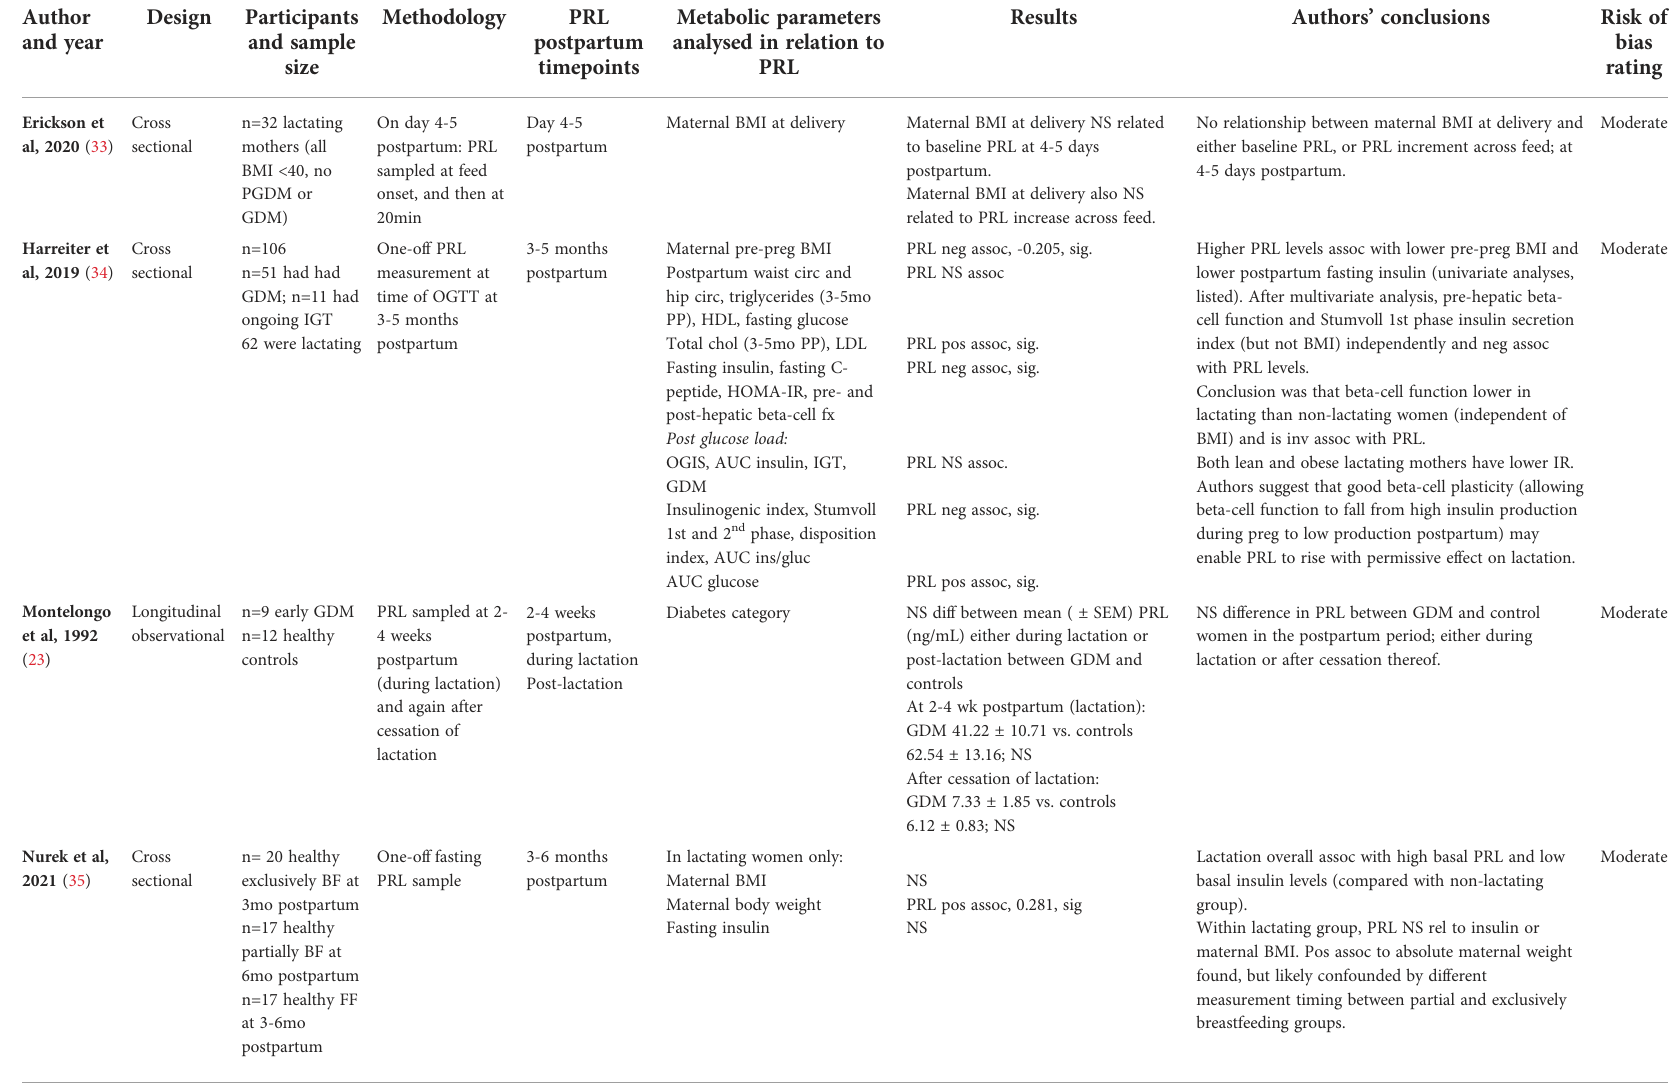
TABLE 3 Studies examining PRL in relation to maternal metabolism during lactation and postpartum – 10